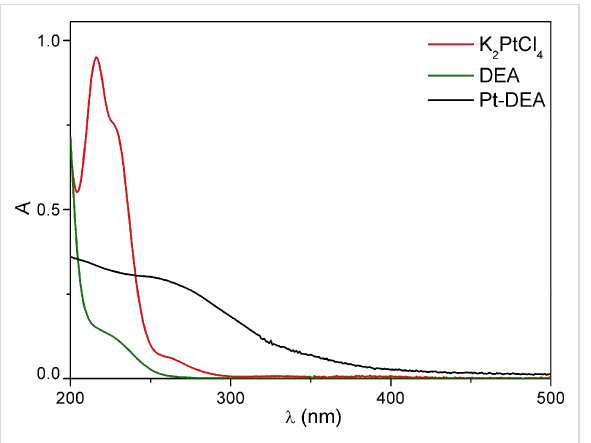
Figure 1: 1 UV–vis spectra in H 2 O of: K 2 PtCl 4 (red); DEA (green); Pt-DEA (black).